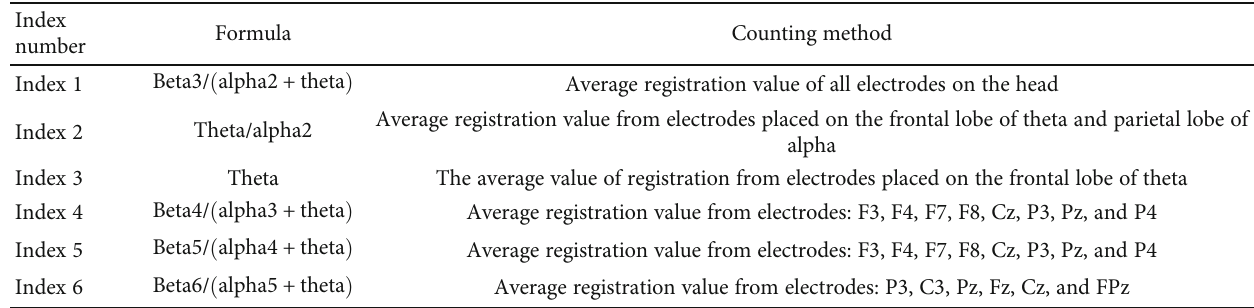
Table 2: Description of the indices used in the test.